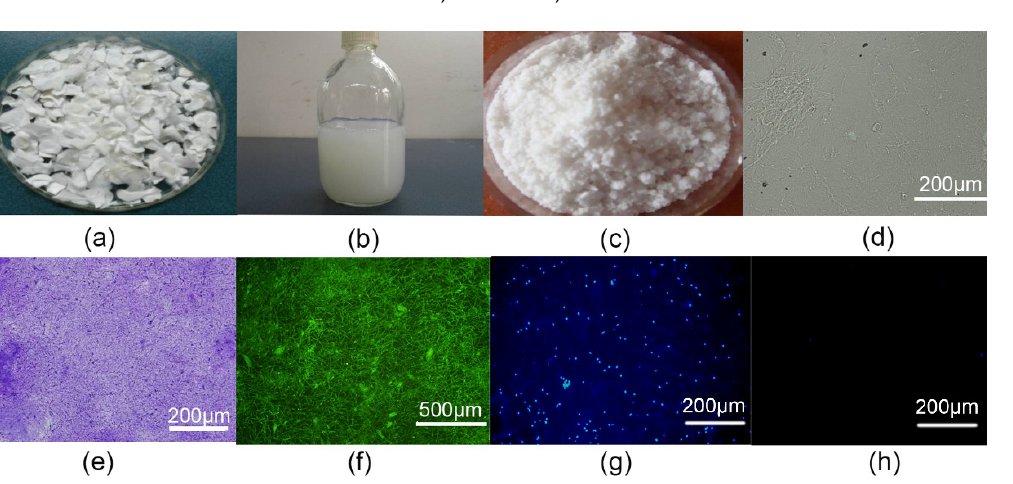
Figure 1. ( a ) Fresh articular cartilage. ( b ) Articular cartilage extracellular matrix (ACECM) slurry with a milky white appearance. ( c ) ACECM dry powder. ( d ) Micro-filament structure of ACECM slurry. ( e ) ACECM smear for toluidine blue staining. ( f ) Positive ACECM smear for collagen type II immunohistochemical staining. ( g ) ACECM slurry smear for Hoechst33258 fluorescence staining before differential centrifugation (light microscopy, ×100 magnification). ( h ) ACECM slurry smear examined by Hoechst33258 fluorescence staining after differential centrifugation (light microscope, ×100 magnification).